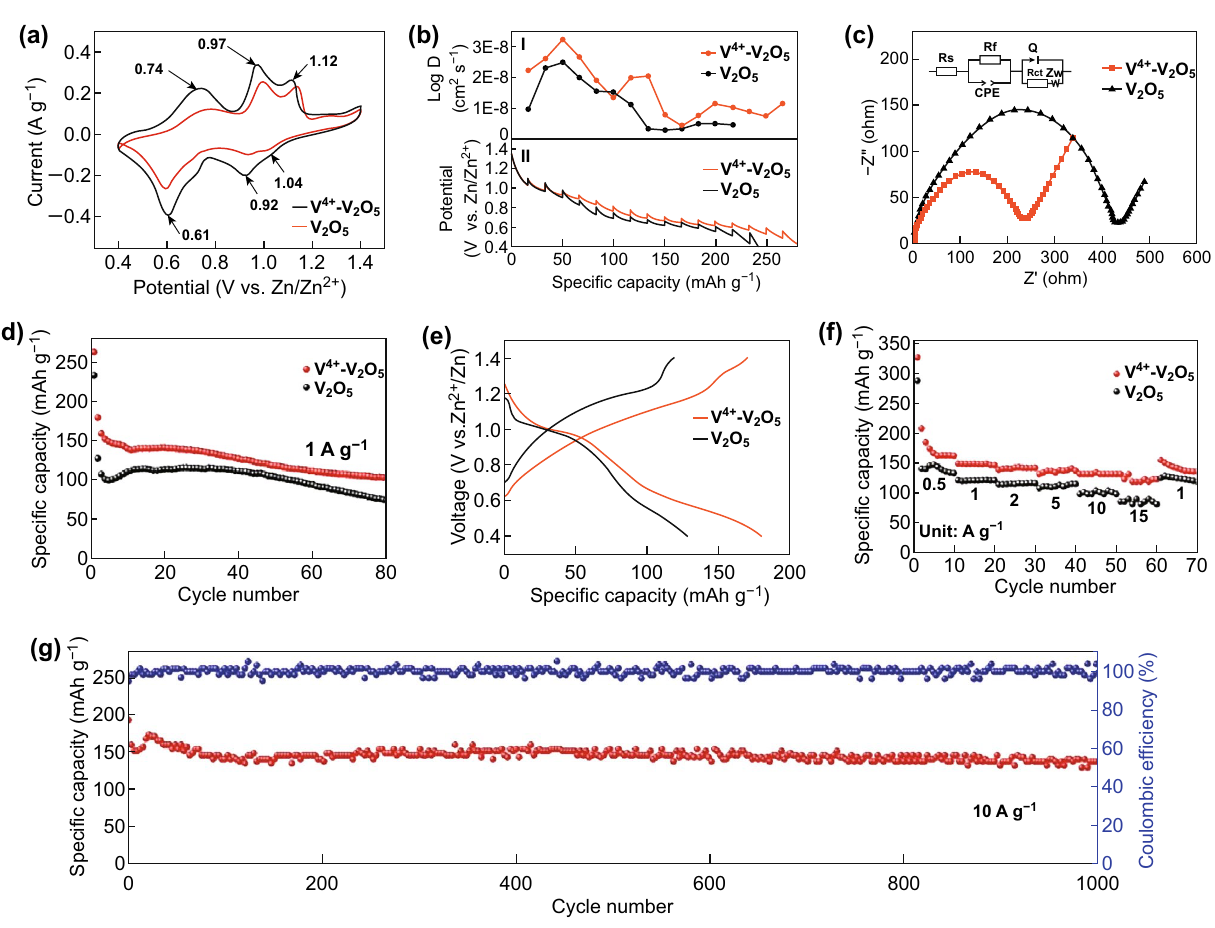
Fig. 3 a The third cycle of the CV curves of the V 4+ -V 2 O 5 and V 2 O 5 electrodes at a scan rate of 0.1 mV s −1 in the voltage range 0.4–1.4 V (vs. Zn/Zn 2+ ). b GITT curves (I) and calculated diffusion coefficients (II) of V 4+ -V 2 O 5 and V 2 O 5 electrodes. c Nyquist plots of V 4+ -V 2 O 5 and V 2 O 5 before cycling. d Cycling performances of V 4+ -V 2 O 5 and V 2 O 5 electrodes at a discharge current density of 1 A g −1 . e Discharge–charge voltage profiles of V 4+